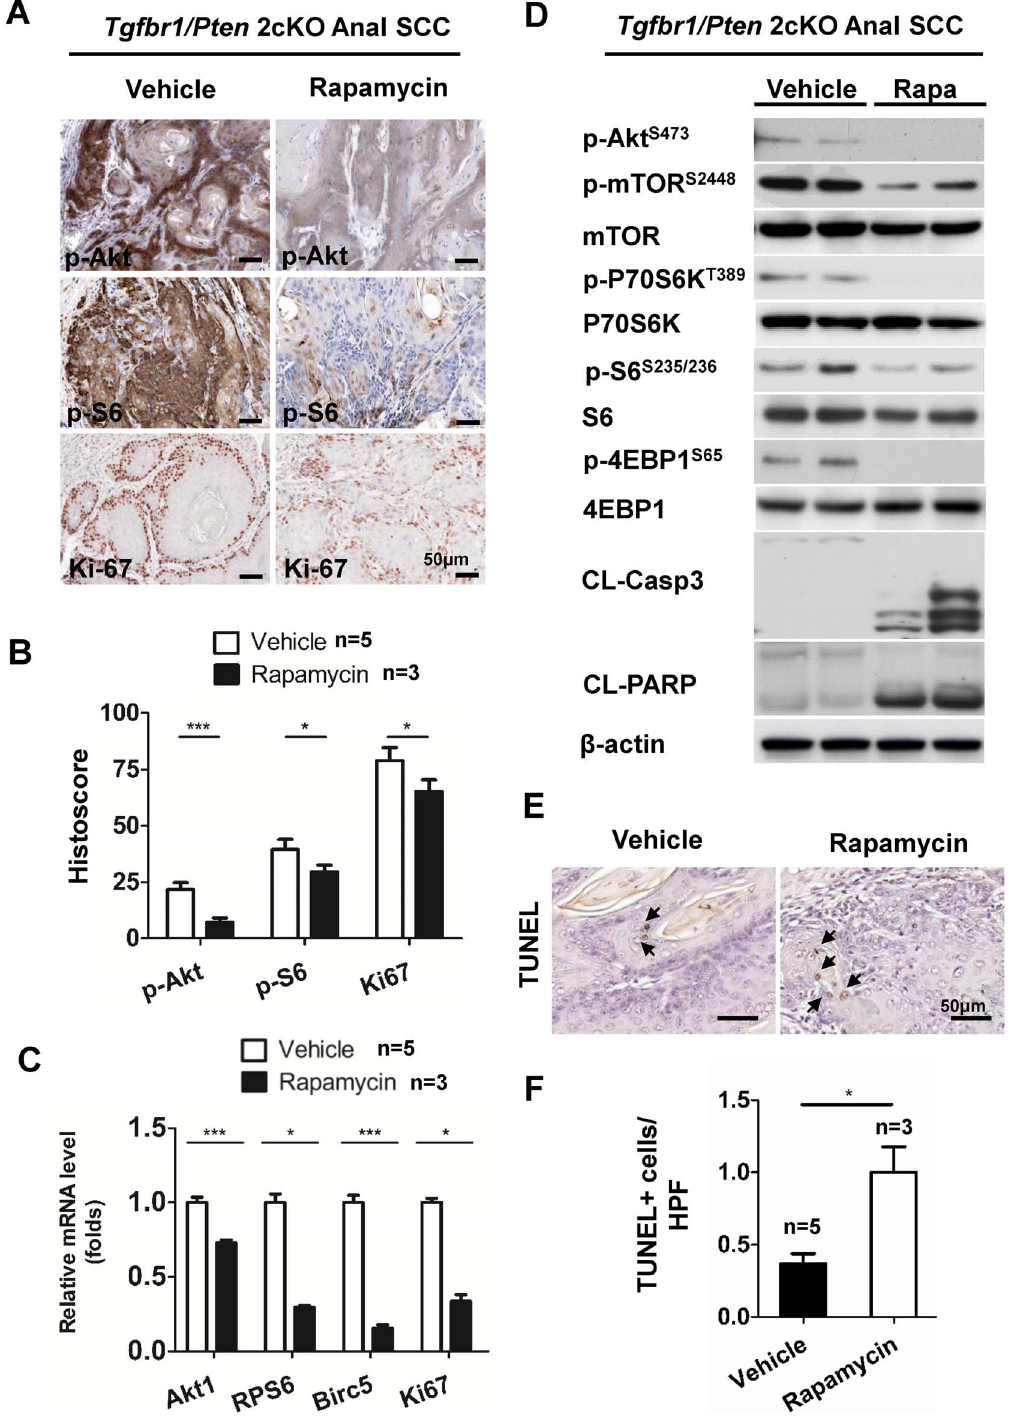
Figure 6. Decrease in Akt/mTOR signaling and cell proliferation in Tgfbr1/Pten 2cKO ASCC after rapamycin treatment. (A), representative immunostaining for p-Akt, p-S6, and Ki67 in vehicle- and rapamycin-treated groups. (B), quantification of staining by histoscores shows a significant decrease in p-Akt, p-S6, and Ki67. (C), Western blot analysis shows significant decrease in the levels of p-Akt, p-mTOR, p-P70S6K, p-S6, and p-4E-BP1 but not in the Akt, P70S6k and S6. Rapamycin treatment increased protein levels of cleaved caspase-3 (CL-Casp3) and cleaved PARP (CL- PARP). Rapa; Rapamycin, (D), Quantification for relative mRNA levels of Akt1, Rps6, Birc5 and Mki67 shows decreased mRNA levels in rapamycin- treated group (n=3) as compared with vehicle-treatedgroup(n=5). (E), increased apoptotic cells were detected by TUNEL in rapamycin- treated group (n=3) as compared with vehicle-treated group (n=5). (F), quantification of TUNEL positive cells per high power field of 20 6 shows increased apoptosis after rapamycin treatment. Mean 6 SEM; *, P , 0.05; ***, P , 0.001; Student t test.